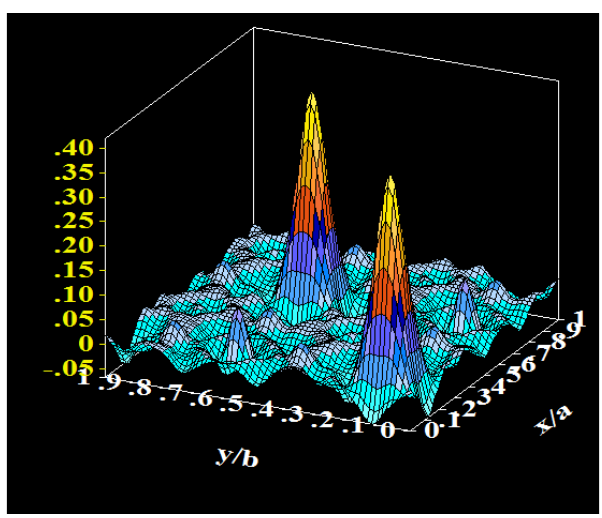
Figure 2. Difference Fourier density map at z= 0.08 showing conspicuous peaks with positive nuclear density at 32 e ( x , x , x ) positions, corresponding to missing O’ atoms of water molecules for KNbW sample.